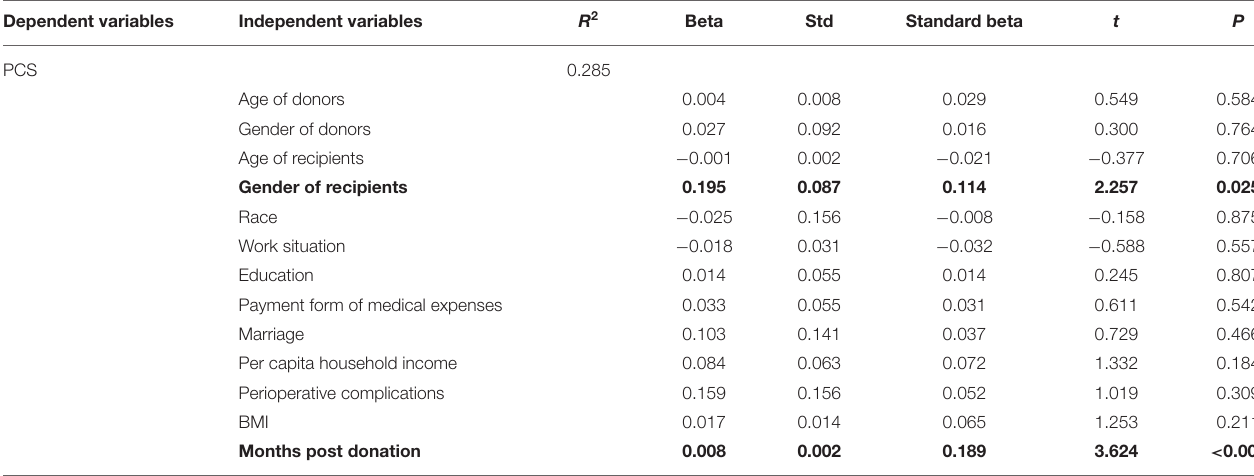
TABLE 7 | Independent influencing factors of the PCS from multivariate analysis ( N =